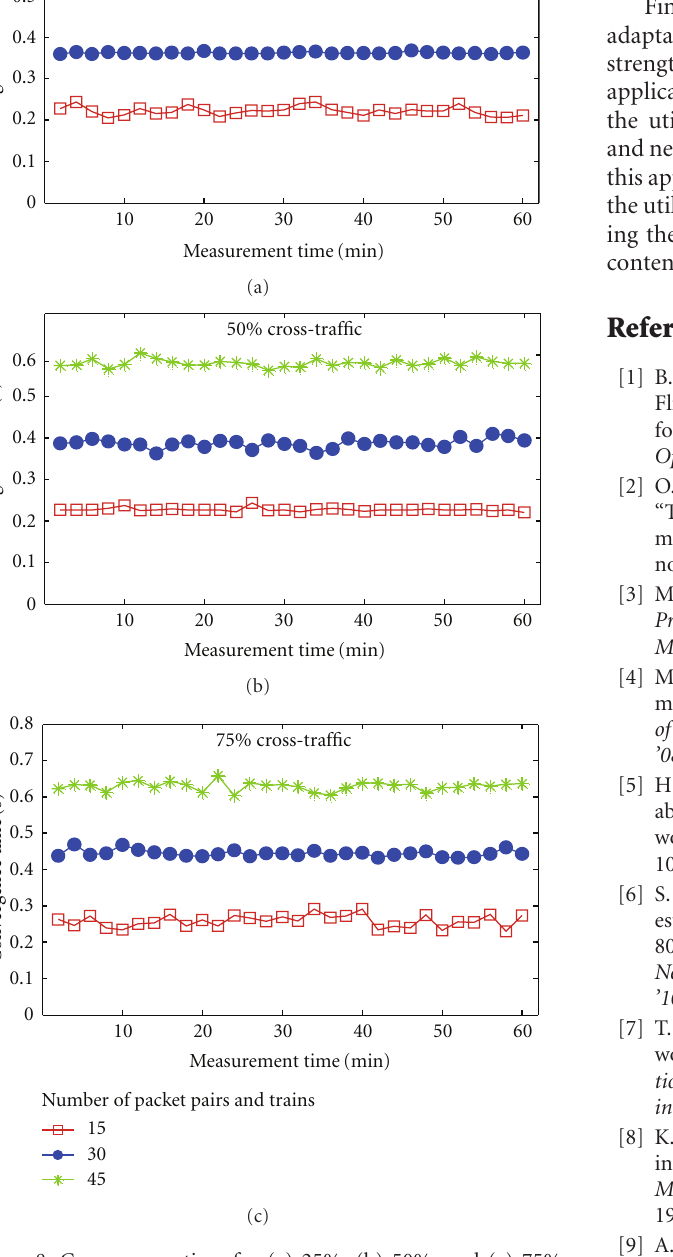
Figure 8: Convergence time for (a) 25%, (b) 50%, and (c) 75% cross-tra ffi